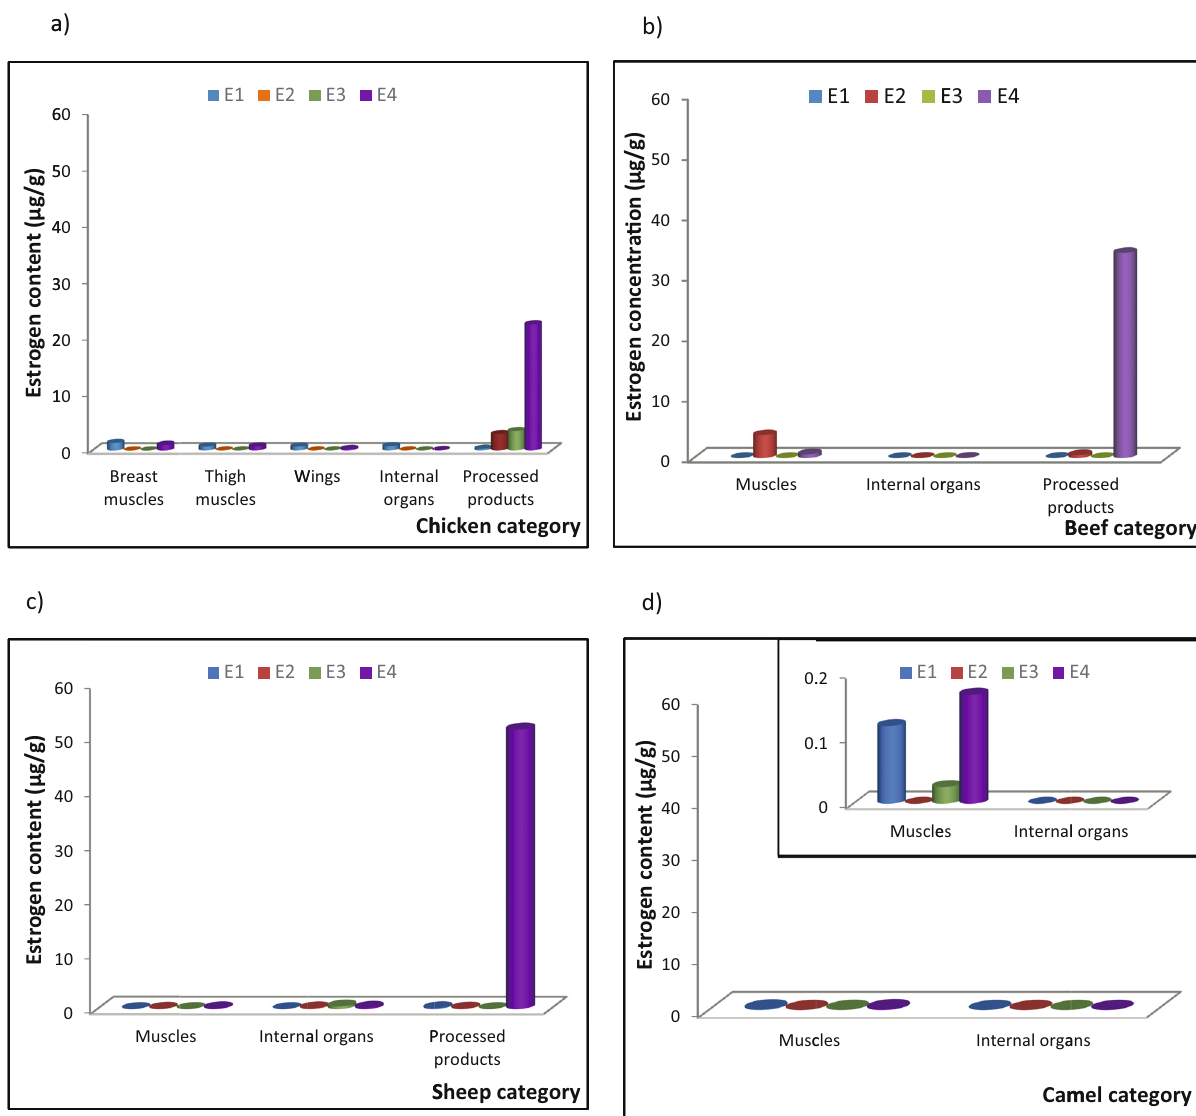
Figure 4: Occurrence of estrogens ( µg/g ) in di ff erent categories of meat samples: ( a ) chicken, ( b ) beef, ( c ) sheep, and ( d ) camel. The same scale of the y - axis was used for